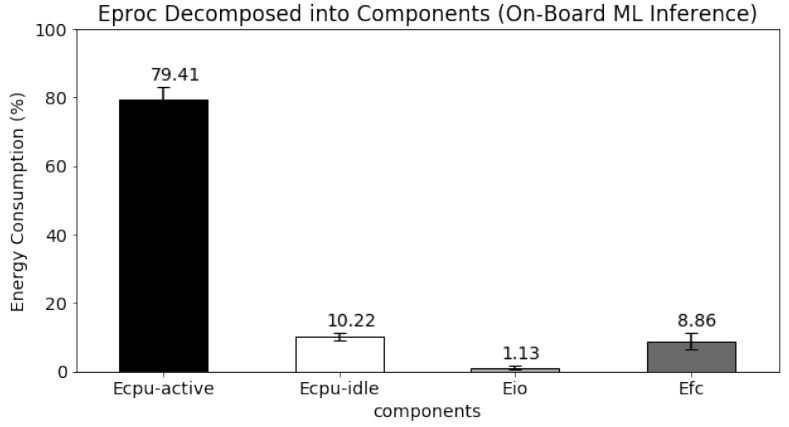
Figure 7. Processing energy decomposed into its sub-components (On-board ML with CNN).